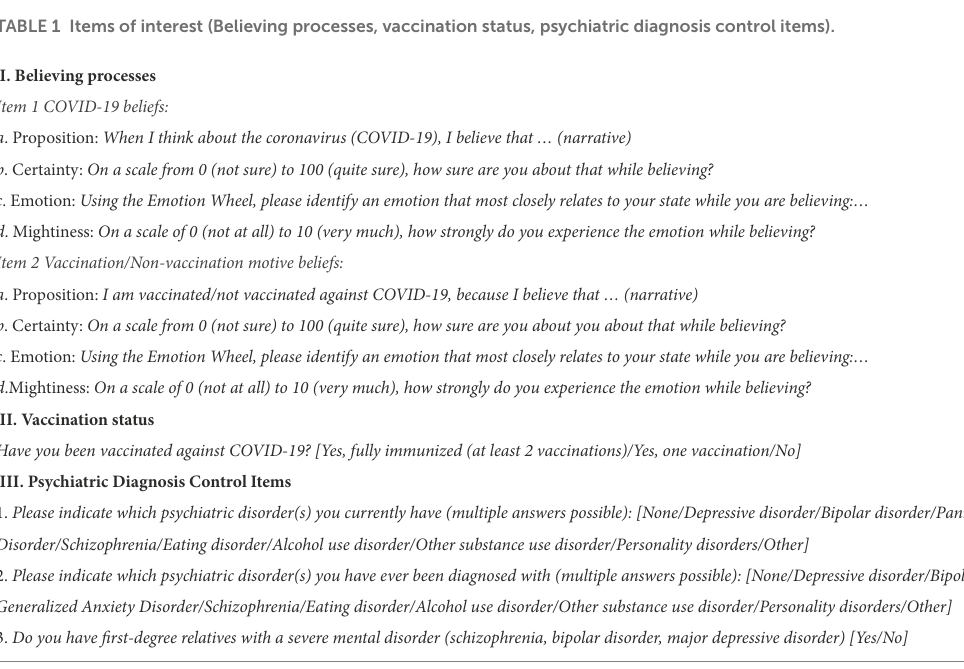
TABLE 1 Items of interest (Believing processes, vaccination status, psychiatric diagnosis control